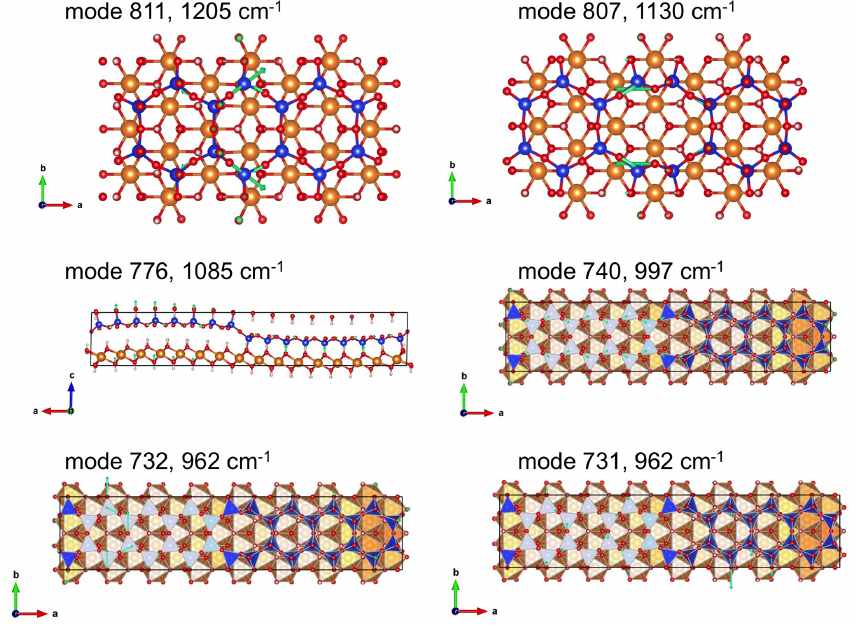
Figure 5. Views of oxygen displacements in selected Si-O stretching modes (green arrows whose length is proportional to the magnitude of atomic displacement). Corresponding Vesta files are reported as supplementary information. Mode number and corresponding experimental frequencies (Table 1) are reported. Note the localization of the modes 811 and 807 on 6- and 8-reversals, respectively. Both the modes 731 and 732 contribute to the band observed at 962cm − 1